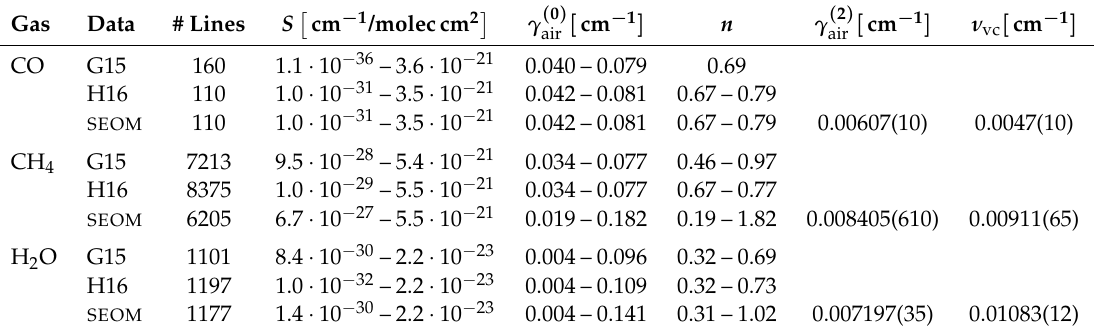
Table 1. A comparison of GEISA2015, HITRAN 2016, and SEOM line data for the 4252.20–4327.90 cm − 1 region. The number of spectral lines along with the corresponding range of intensities S , air broadening HWHM γ air and temperature exponents n are shown. In the last two columns the mean of the non-zero air-broadening speed-dependence parameters γ ( 2 ) and the Dicke narrowing parameters ν vc air are given, the number of non-zero values is indicated in the parentheses. In GEISA HDO is treated as an individual species, in the table here these 660 lines are included in the H 2 O entry. Please note that in HITRAN2016 the CH 4 line at ˆ ν = 4270.377259cm − 1 has an incorrect temperature dependence of n = 7.7 (correct n = 0.7) and lines at ˆ ν = 4255.703126cm − 1 , 4291.829949cm − 1 , and 4291.840848cm − 1 list n = 0, respectively (I.E., Gordon, personal communication). Furthermore, the lower-state energy of